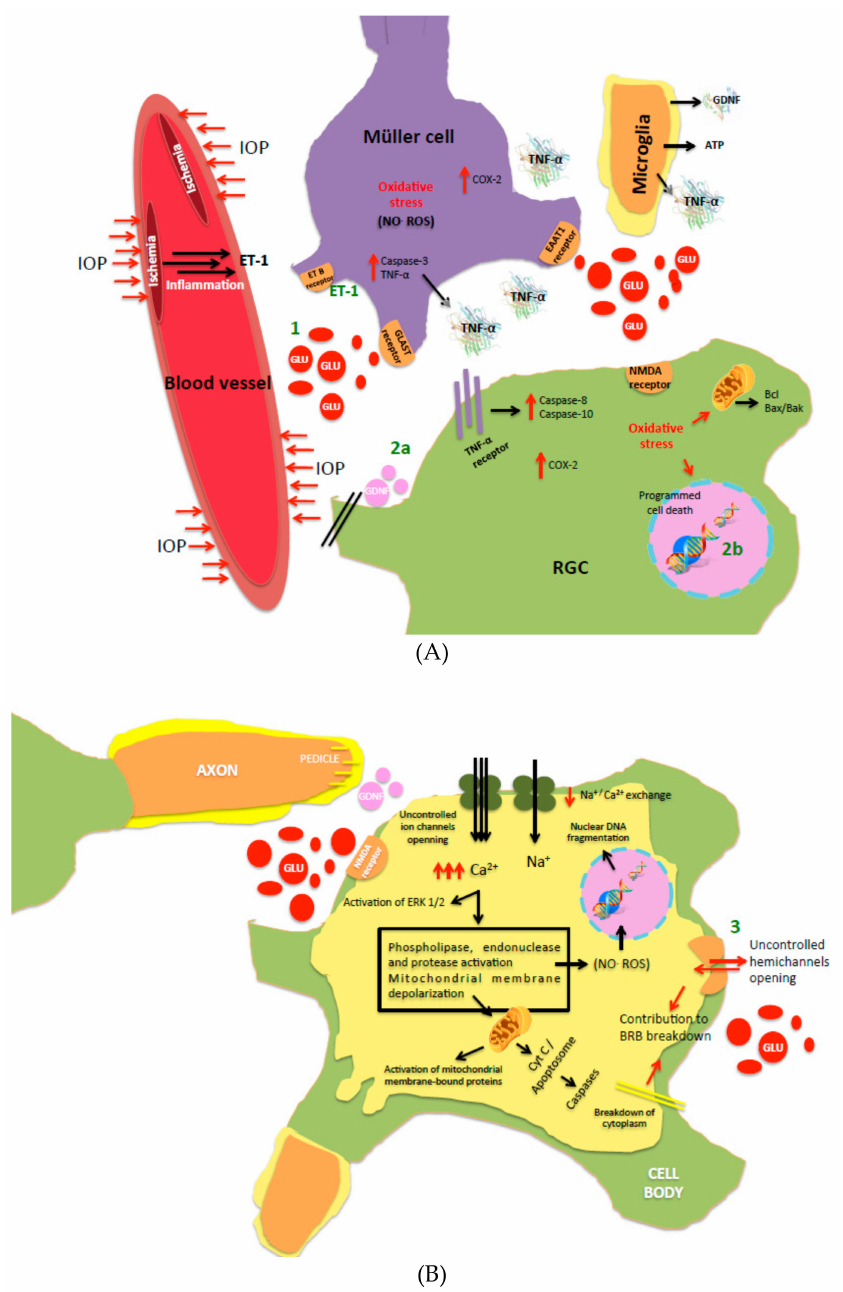
Figure 1. Schematic representation of ( A ) a synapse where intraocular pressure (IOP) and inflammation are causing optic nerve damage through excitotoxicity and the events that occur in retinal ganglion cells (RGC), Müller cells and microglia; ( B ) intracellular mechanisms activated in RGC after accumulation of excess glutamate in the synapse that lead to apoptosis. A detailed study can be found in [18] and [5]. Possible interventions to reduce excitotoxicity are indicated; 1) represents intervention over excess glutamate, 2a) administration of neurotrophic factors, 2b) administration of antiapoptotic compounds and 3) maintenance of retinal structure